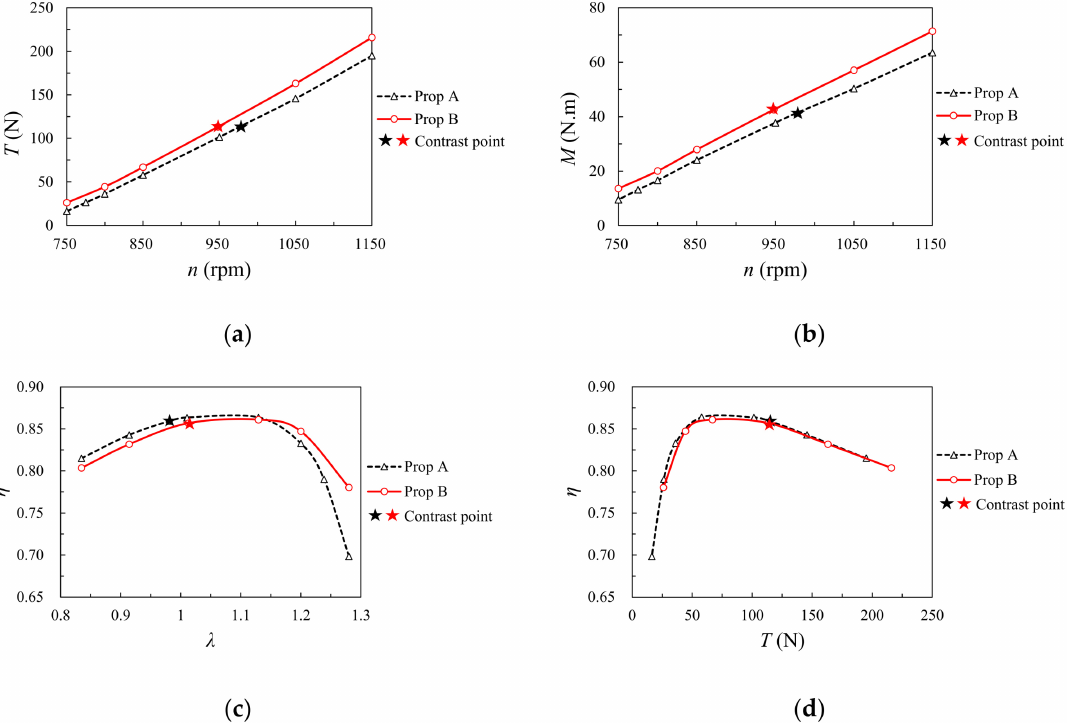
Figure 21. Aerodynamic performances of two optimized propellers under an average Reynolds number of about 1.8 × 10 5 : ( a ) Thrust vs. rotational velocity; ( b ) Torque vs. rotational velocity; ( c ) Efficiency vs. advance ratio; ( d ) Efficiency vs. thrust.